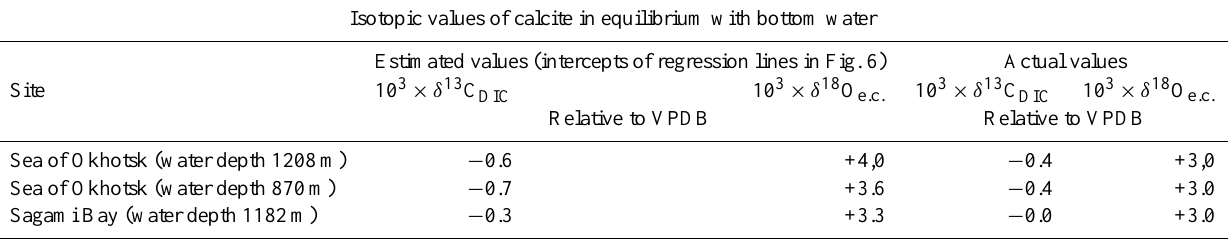
in Fig. 6) and the actual isotopic values of calcite in equilibrium with bottom water.